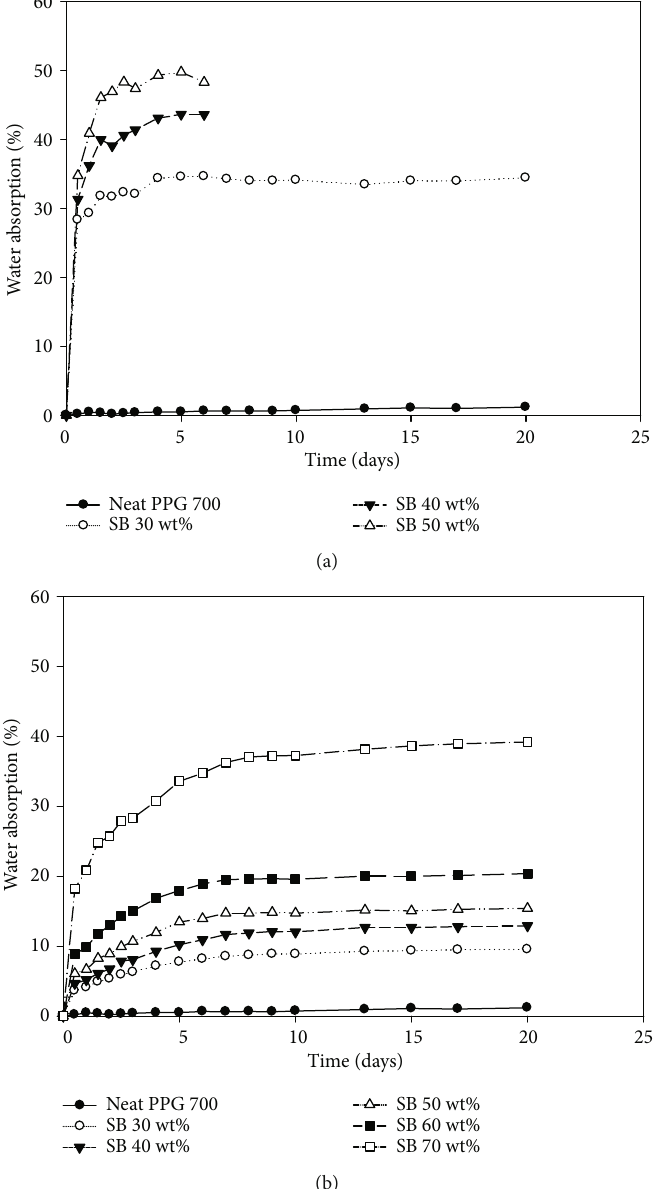
Figure 9: Water absorption property of PPG 700 PU-EP elastomers: (a) untreated bioadditive IPN and (b) GPS-treated bioadditive